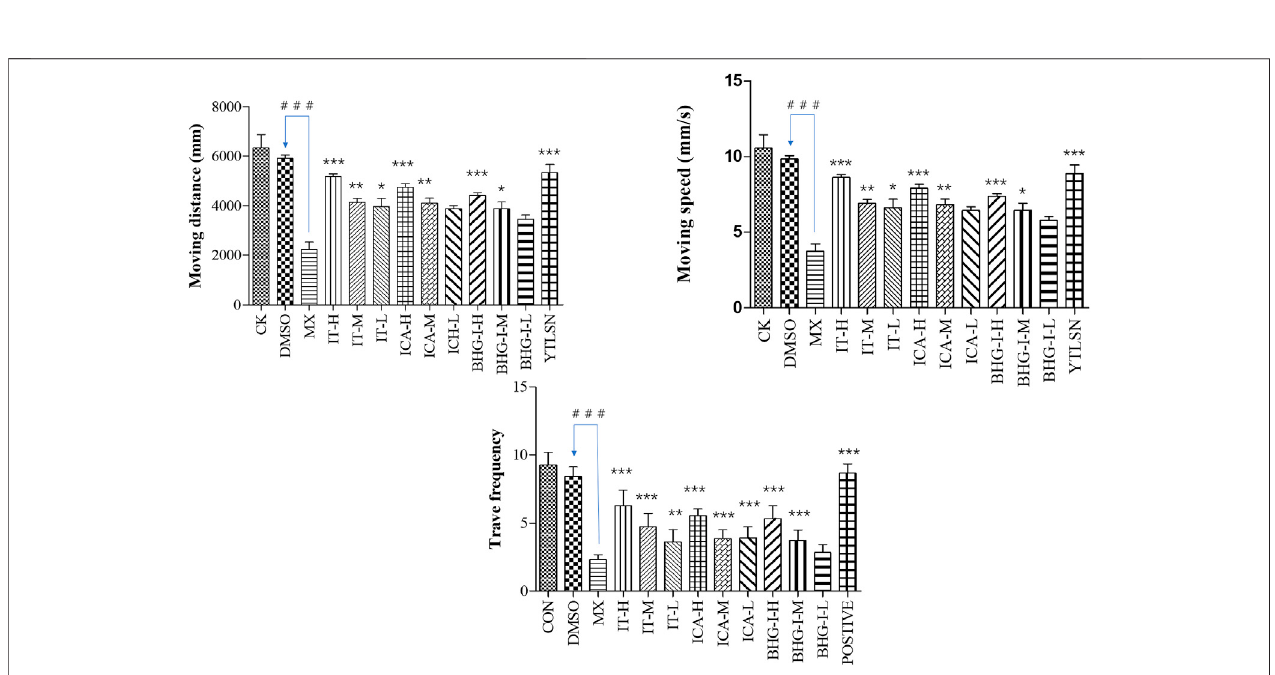
FIGURE 5 | Effect of ICA, IT, and BHG-I on behavioral analysis ( n = 15). CK, blank E 3 medium; DMSO, 0.5% DMSO; MX, 25 μ M PNSL; YTLSN, 15 μ M disodium ethydronate + 25 μ MPNSL;ICA,0.1,1.0or10.0 μ MICA + 25 μ MPNSL;BHG-I,0.1, 1.0,or10.0 μ MBHG-I + 25 μ MPNSL;IT,0.1,1.0or10.0 μ MIT + 25 μ MPNSL. ### p < 0.001 compared with DMSO. * p < 0.05 compared with MX. ** p < 0.01 compared with MX. *** p < 0.001 compared with MX.